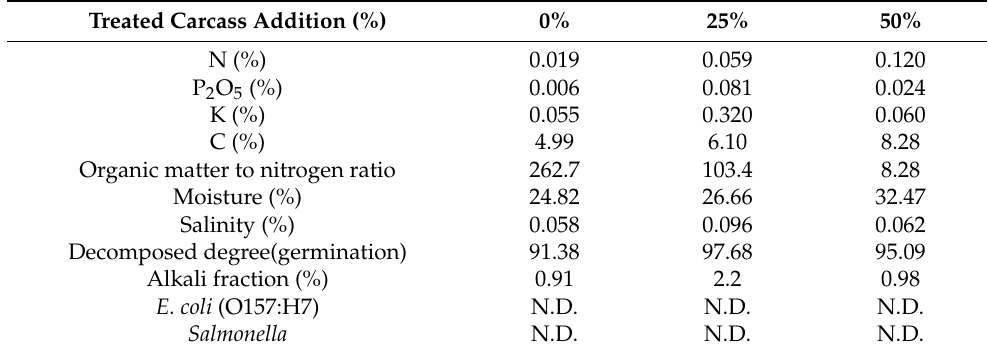
Table 4. Properties of nutrient-poor soil amended with 0%, 25%, and 50% treated carcass